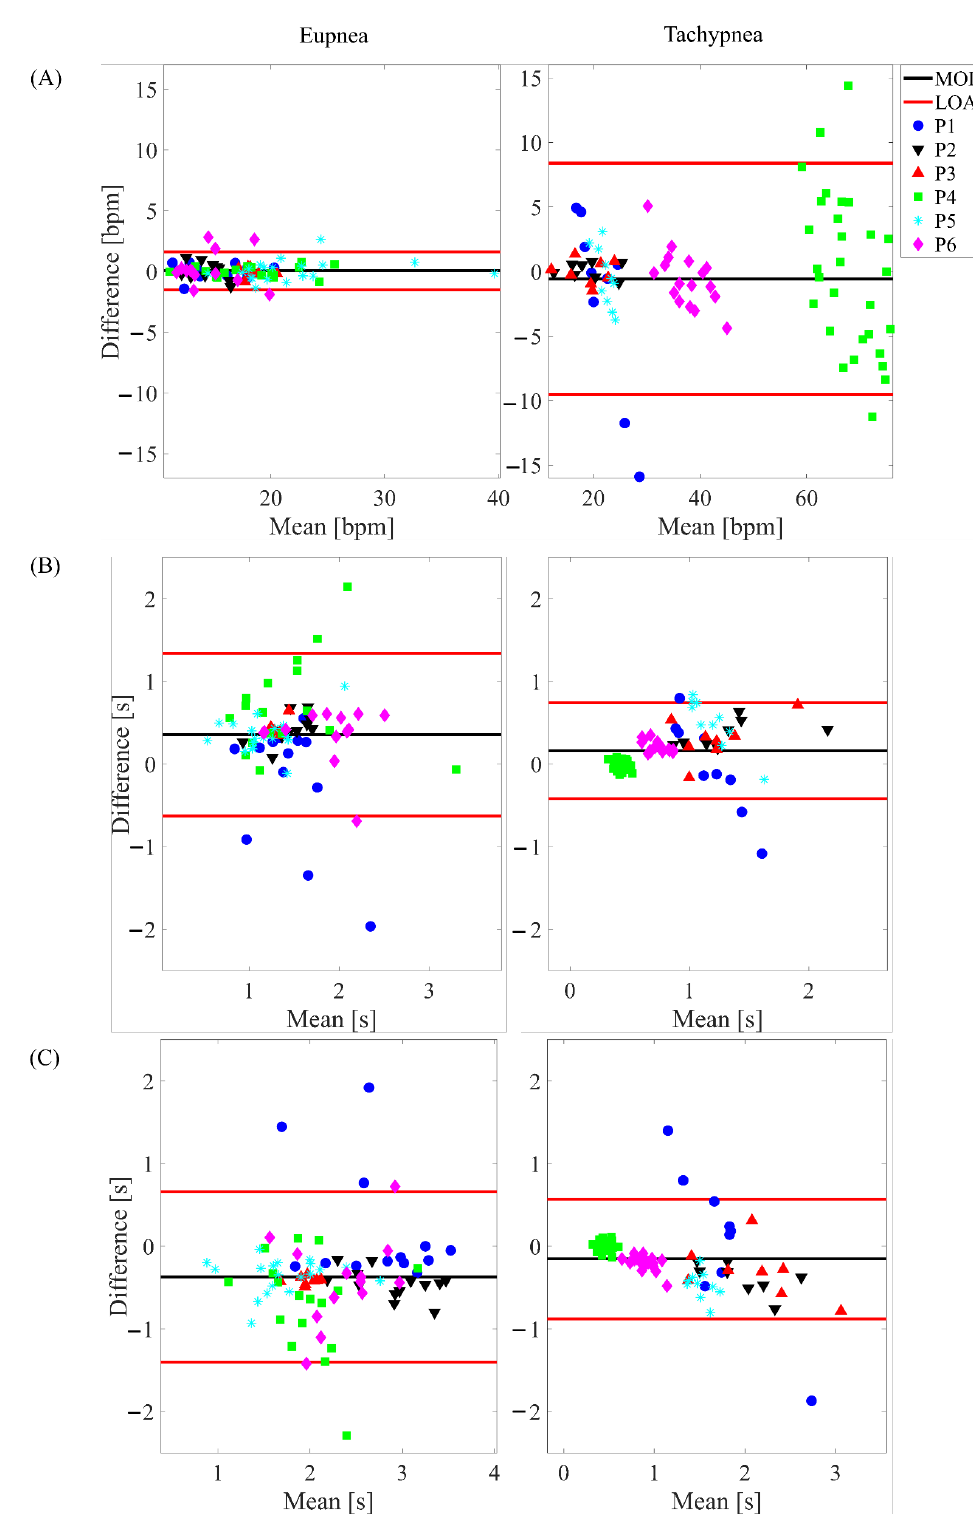
Figure 7. Bland-Altman plots depicting the estimated ( A ) f r , ( B ) t i and ( C ) t e on the respiratory signal retrieved from the healthy side in eupnea and tachypnea